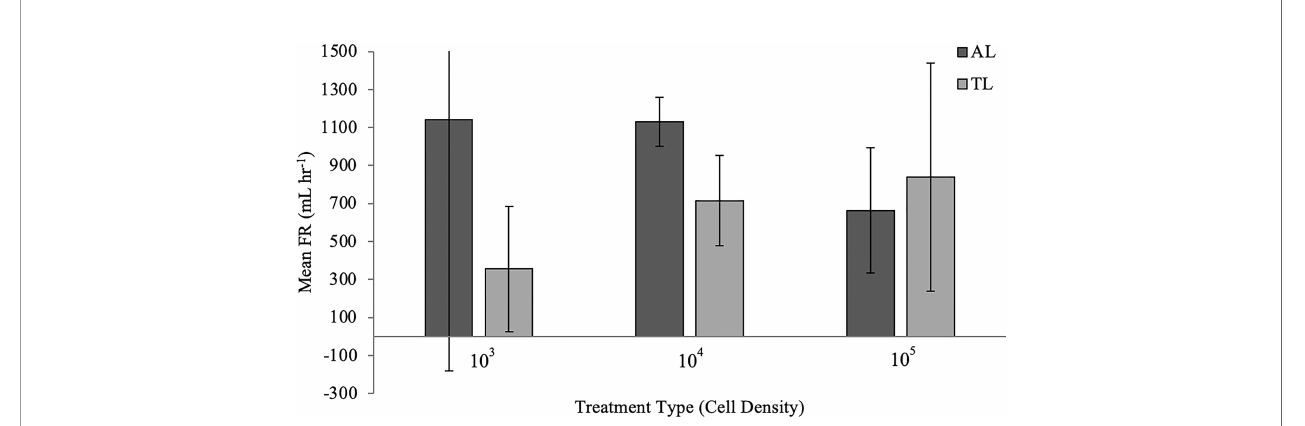
FIGURE 5 | Mean (± s.d., n=3) FR (mL hr -1 ) for Styela plicata exposed to Aureoumbra lagunesis (AL) or Tisochrysis lutea (TL, control) at varying starting cell densities (x-axis; cells mL -1 ).